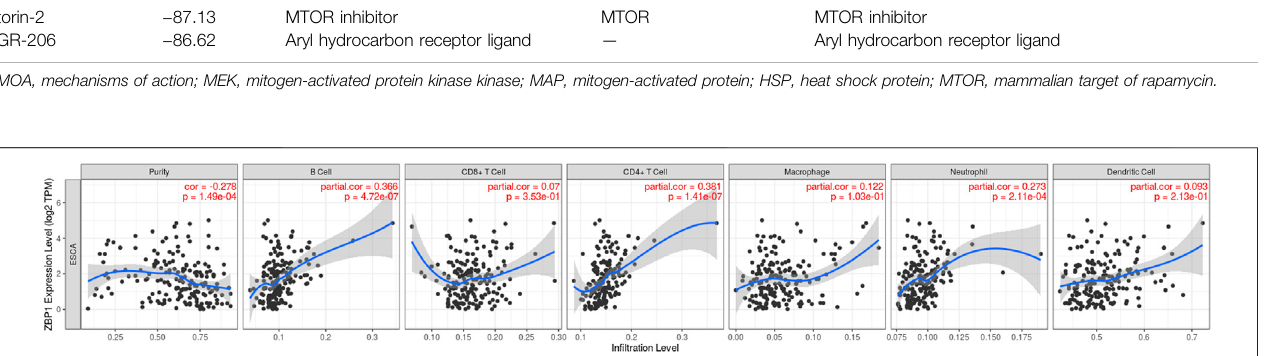
Frontiers in Pharmacology |